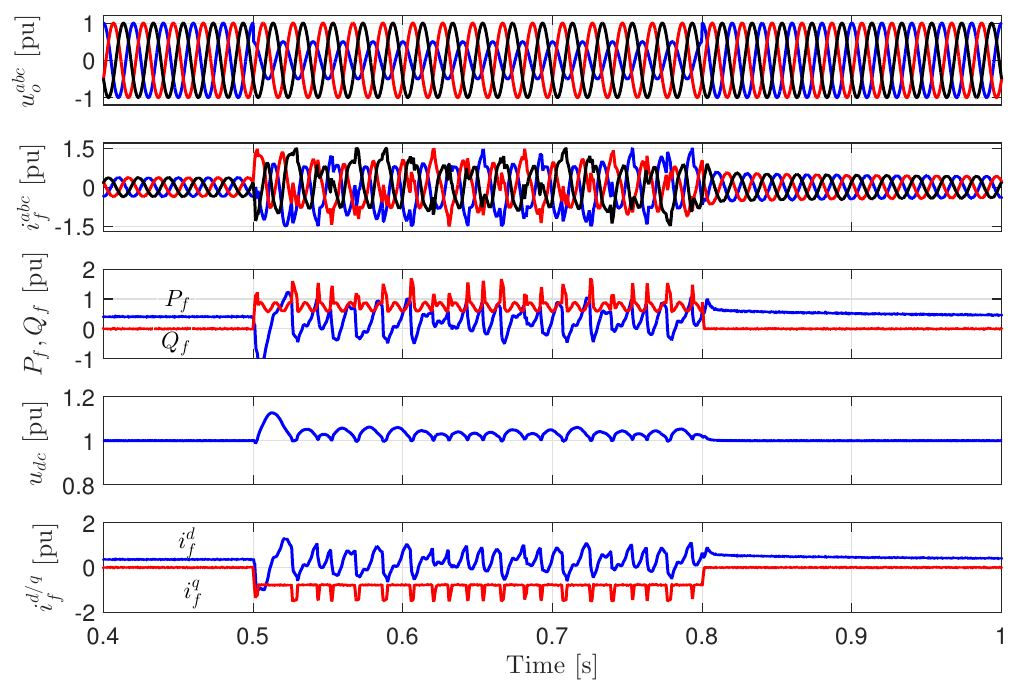
Figure 8. Performance of the GSC and DC-link during a single phase to ground fault with the proposed FRT strategy (from top ): grid voltages u abc o = ( u a o , u b o , u c o ) (cid:62) , GSC output currents i abc active and reactive power injected to the grid ( P f , Q f ), DC-link voltage u dc , and d - and q -axis currents of the GSC ( i d , i q f f